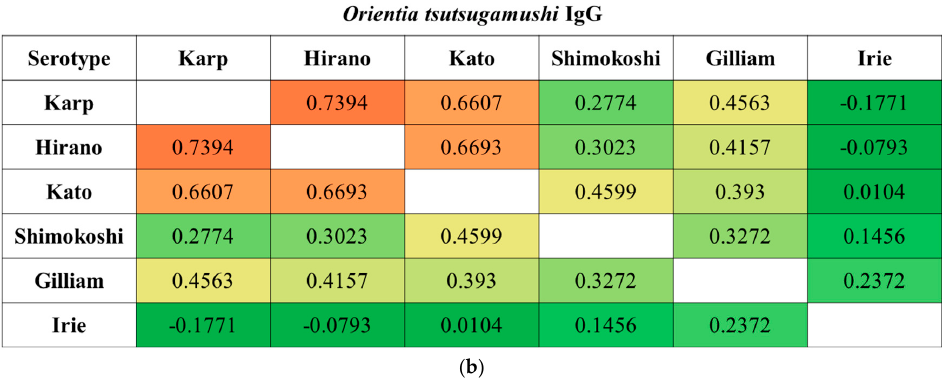
Figure 2. Spearman’s rank correlation coefficients between each O. tsutsugamushi serotype. The correlation coefficients in IgM ( a ) and IgG ( b ) samples were calculated using titers when a diagnosis of scrub typhus was made ( n = 190): paired samples, n = 138; single sample, n = 52. Abbreviations: Irie, Irie/Kawasaki; Hirano, Hirano/Kuroki.